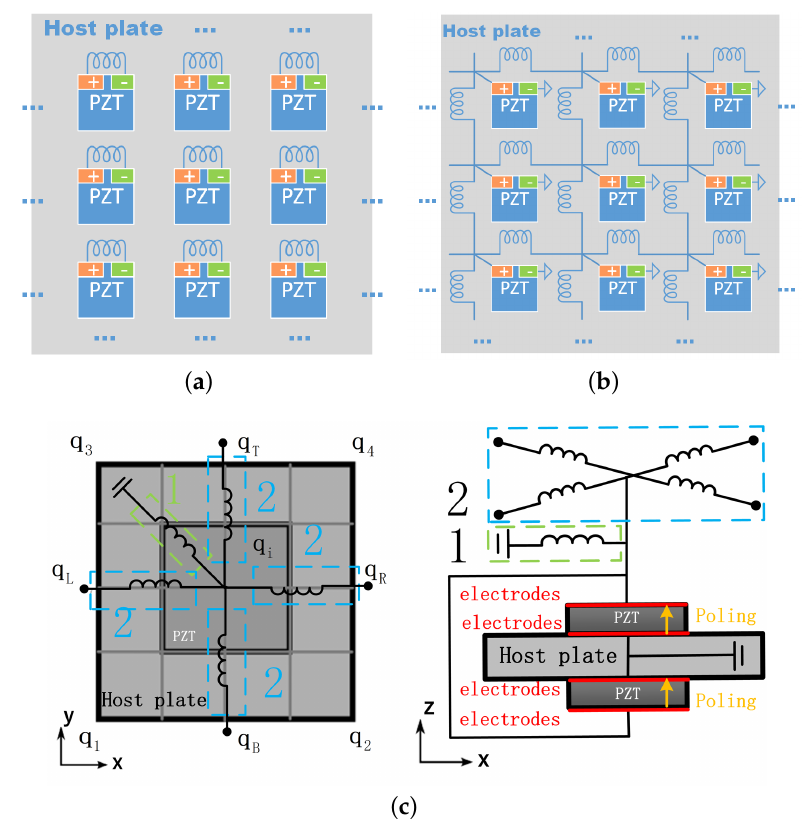
Figure 2. Piezoelectric composite plates with ( a ) local shunting impedance and ( b ) one form of the global electric impedance (considered in this paper). The unit cell of the piezoelectric composite plates is shown in ( c ), where ‘1’ and ‘2’ refer to shunting and network circuits